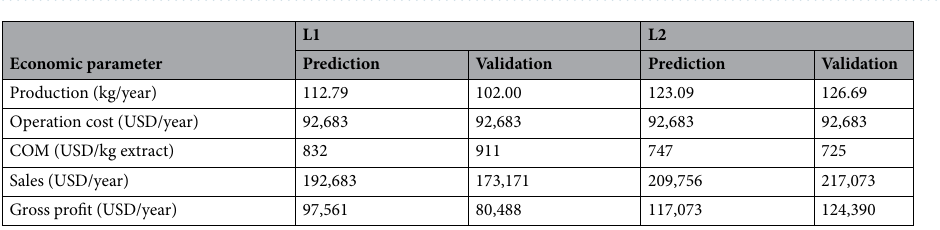
Table 11. Economic evaluation of 0.5 kg feed capacity for L1 and L2 operating conditions by using data from scale-up prediction and scale-up validation. L1: P = 200 bar, T = 60 °C, 50% ethanol–water co-solvent, L2: P = 262 bar, T = 80 °C, 30% ethanol–water co-solvent, COM: cost of manufacturing.